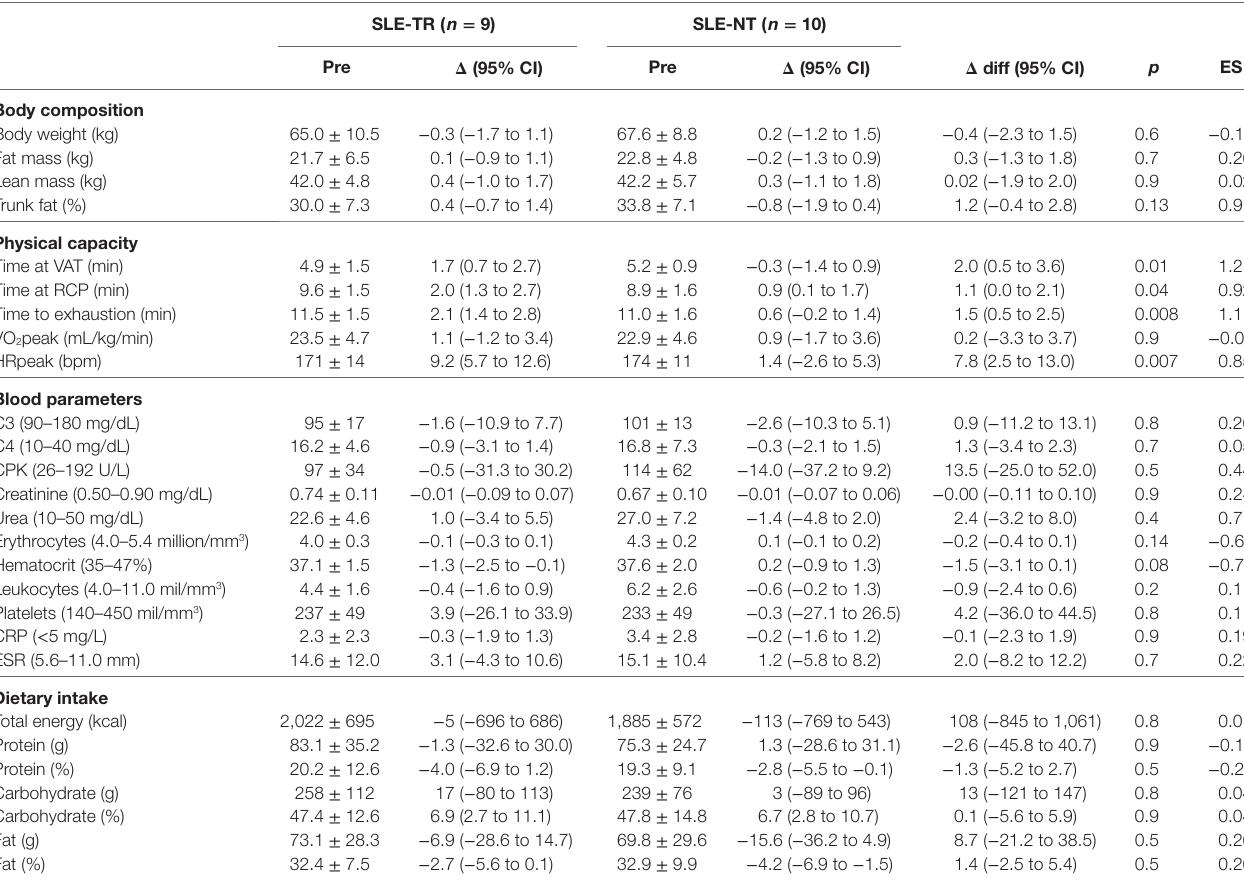
TABLE 3 | Body composition, physical capacity, blood parameters, and food intake in trained and non-trained SLE patients before and after the exercise